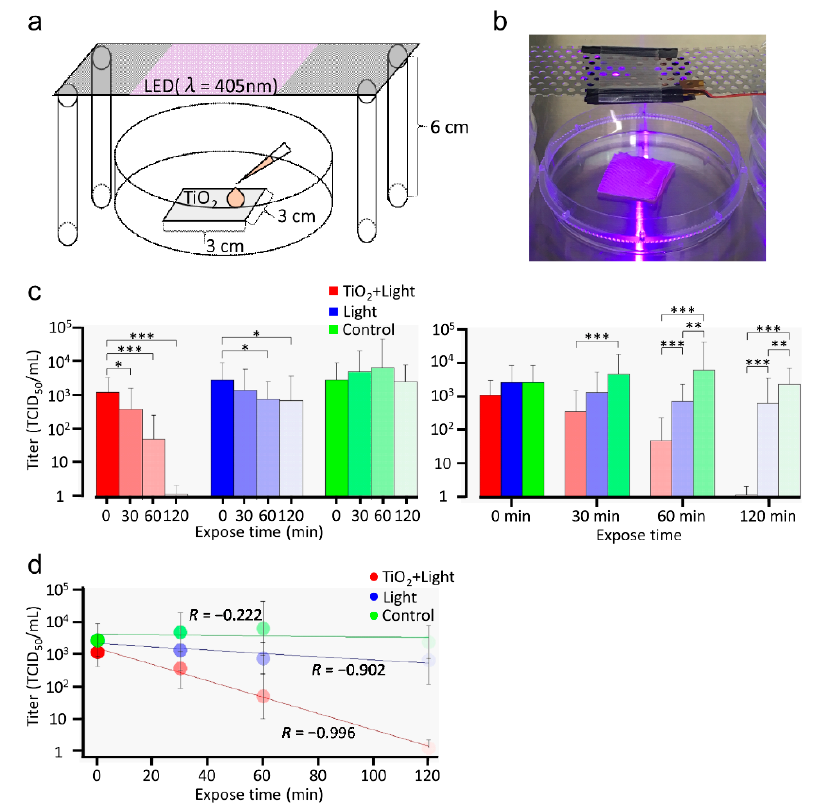
Figure 1. Inactivation of SARS-CoV-2 in liquid by LED-TiO 2 photocatalytic reaction. Schematic diagram ( a ) and images ( b ) of TiO 2 -coated sheet (3 cm × 3 cm) placed a 10-cm dish and exposed to light emitting diode (LED) light with a wavelength of 405 nm placed 6 cm above the dish. In the TiO 2 + Light group, SARS-CoV-2 (1 mL) titer (1.0 × 10 5 TCID 50 /mL) was placed on the TiO 2 -coated sheet. In the Light and control groups, SARS-CoV-2 was directly placed on 10-cm dishes. In the TiO 2 + Light and Light groups, SARS-CoV-2 were exposed to LED light for 0, 30, 60, or 120 min. Then, SARS-CoV-2 were collected by adding 9 mL PBS. ( c ) After the photocatalytic reaction, viral titer was confirmed by TCID 50 assay. Each column and error bar represents the mean ± SD of the results for two independent experiments. All values in each group were compared with those of the 0 min sample by two-way ANOVA with Dunnett’s test (left panel). All values at each time point were analyzed by two-way ANOVA followed by Tukey’s test (right panel). Asterisk indicates a statistically significant difference (* p < 0.05; ** p < 0.01; *** p < 0.001). ( d ) Linear regression analysis was used to examine the correlation between LED-TiO 2 photocatalytic reaction duration and SARS-CoV-2 infectivity. R indicates the Pearson correlation coefficient.